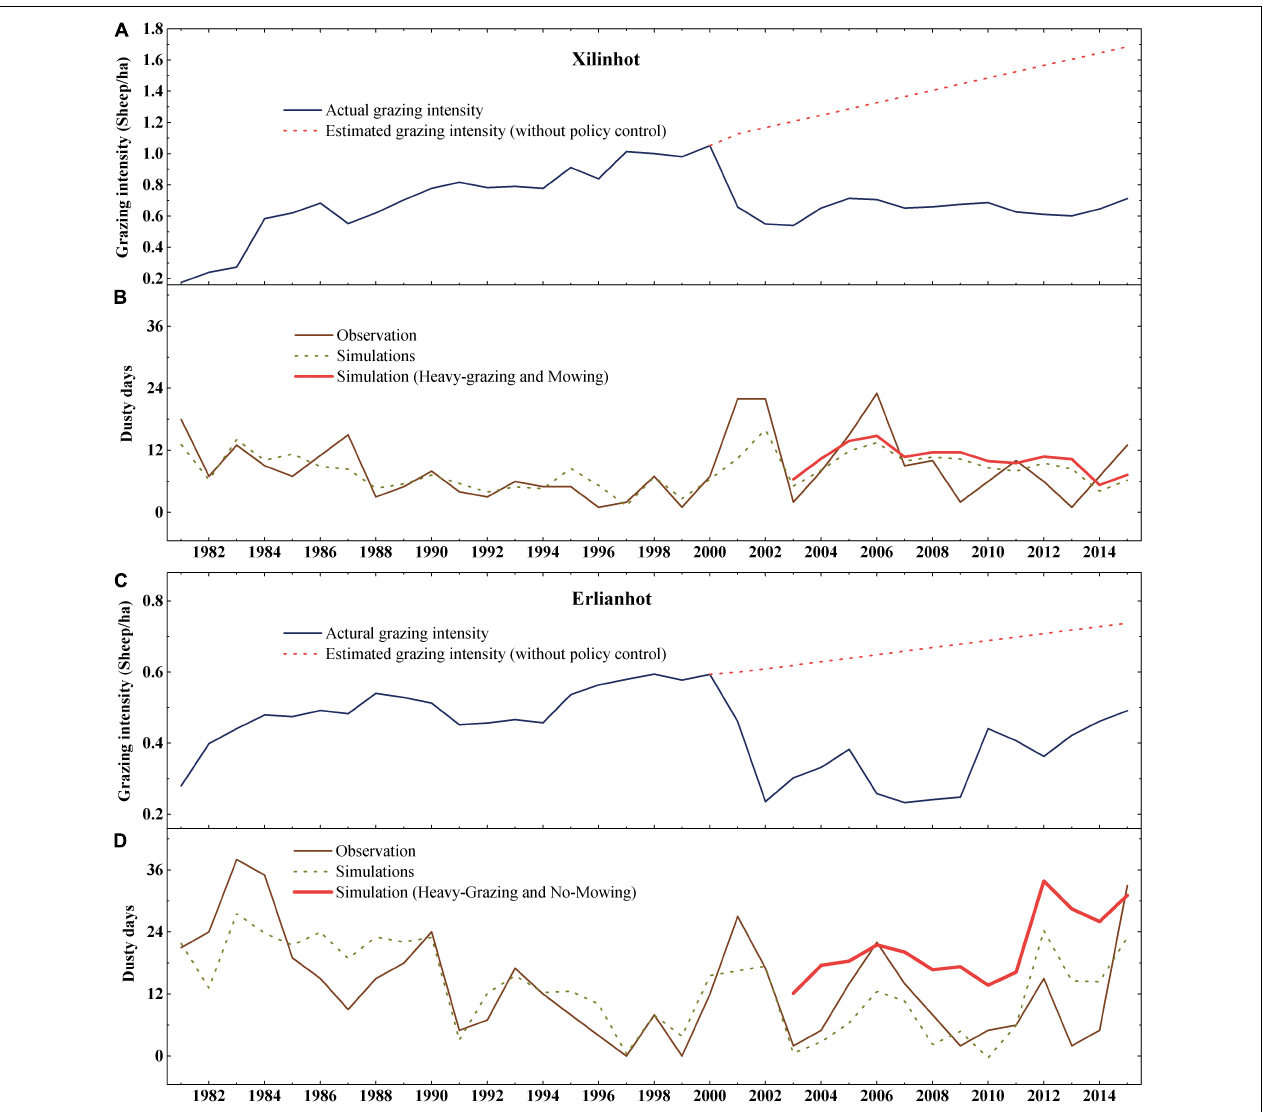
FIGURE 4 | Actual grazing intensity (blue) during 1981–2015 and estimated grazing intensity (without policy controls) during 2003–2015 (red) in Xilinhot (A) and Erlianhot (C) ; Observed and simulated dusty days (dots) with actual grazing intensity during 1981–2015 and simulated dusty days without policy control during 2003–2015 (red) in Xilinhot (B) and Erlianhot (D)